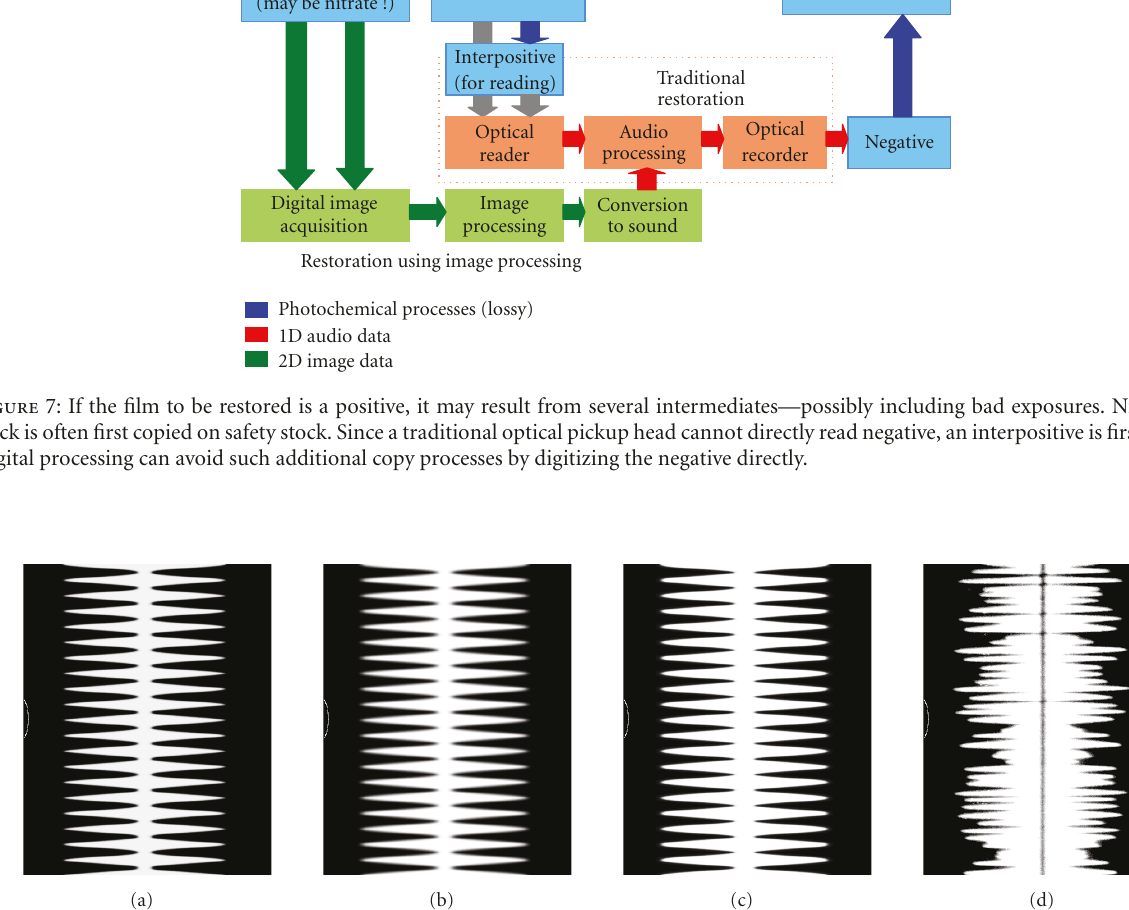
To check our simulation, we generate a sweep signal (sine wave, from 50 Hz to 10 kHz). After a simulated overexposure, the output spectrogram is shown in Figure